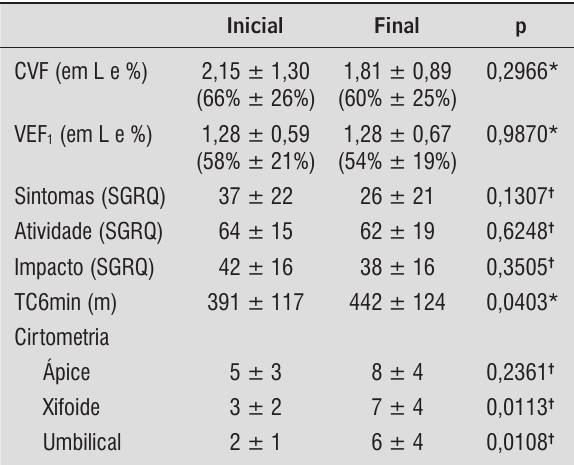
Na Tabela 2 estão apresentados os valores